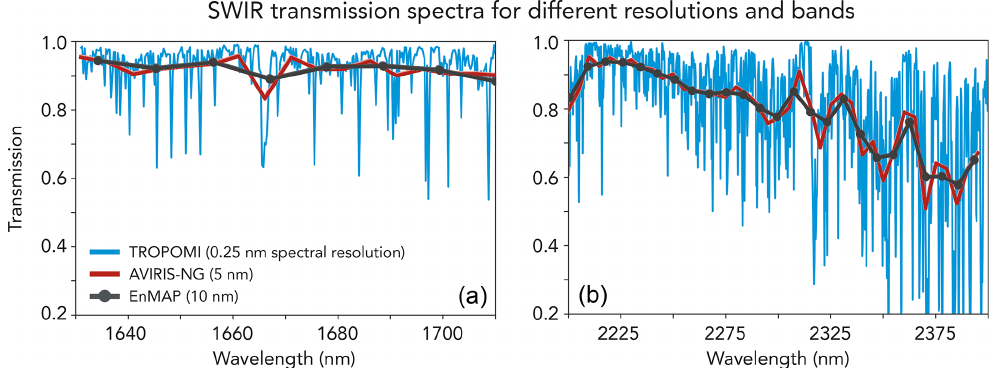
Figure 1. Simulated top-of-atmosphere (TOA) transmission spectra for different spectral resolutions (FWHM: full width at half maximum) in the 1650 (a) and 2300nm (b) shortwave infrared (SWIR) bands. High-resolution spectra were simulated for the US Standard Atmosphere with 1800ppb total column methane using the HITRAN spectroscopic database and the HITRAN Application Programming Interface (HAPI) tool (Kochanov et al., 2016), and they were then sampled with spectral resolutions of 0.25nm (TROPOMI), 5nm (AVIRIS-NG), and 10nm (EnMAP) at the appropriate wavelength positions.